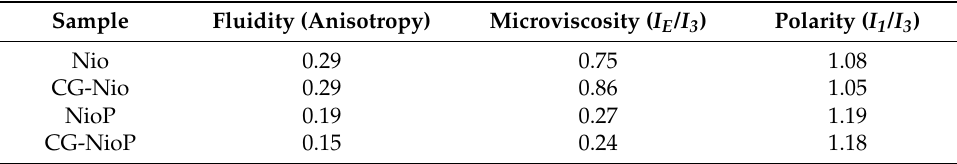
Table 3. Uncoated and CG coated Nio and NioP bilayer